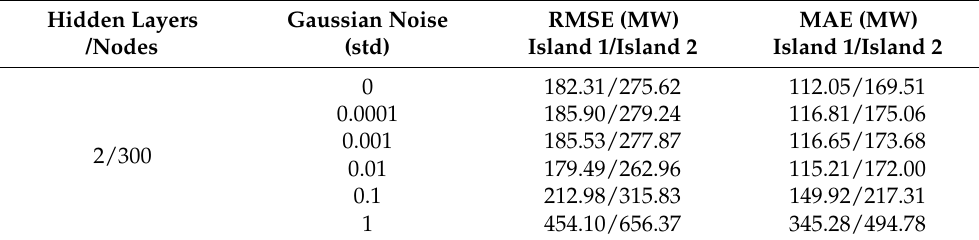
Table 3. Performance of trained model with Gaussian Noise regularization techniques. Hidden Layers